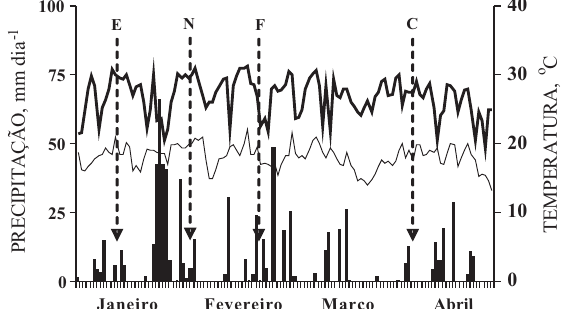
Figura 1. Precipitação pluvial ( ) e temperaturas máxima ( do experimento, durante os meses de janeiro